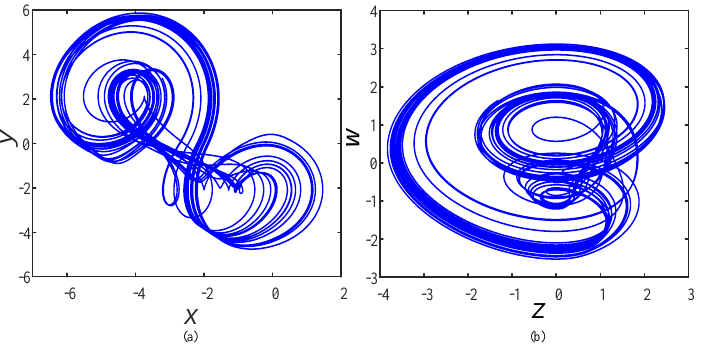
Figure 1. Phase diagrams of the system: ( a ) x − y plane; ( b ) z − w